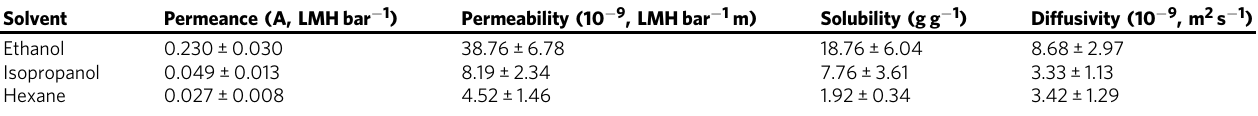
Table 2 Solvent transport properties in the membrane